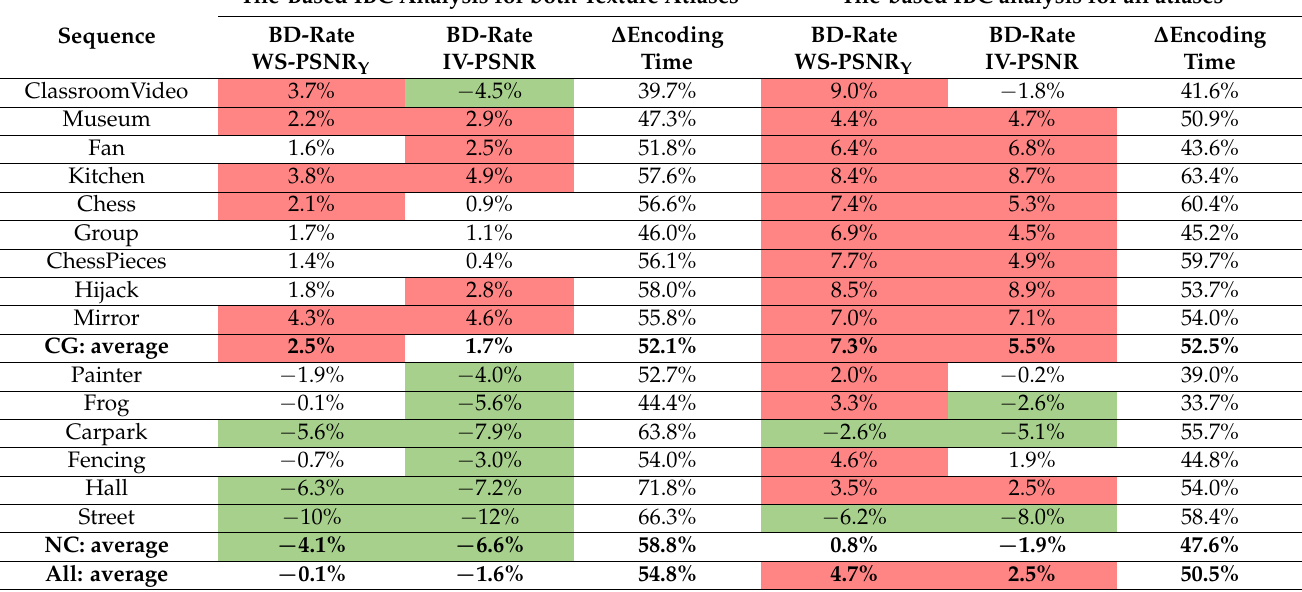
Table 5. Basic SCC vs. SCC with quarter-pel IBC accuracy and tile-based IBC analysis for other atlases; BD-rates for two used quality metrics (WS-PSNR and IV-PSNR, a negative value indicates increased coding efficiency) and increase of the encoding time when compared to basic SCC (value higher than 100% indicates longer computational time); BD-rate change higher than 2% was highlighted in red (for efficiency loss) or green (for efficiency